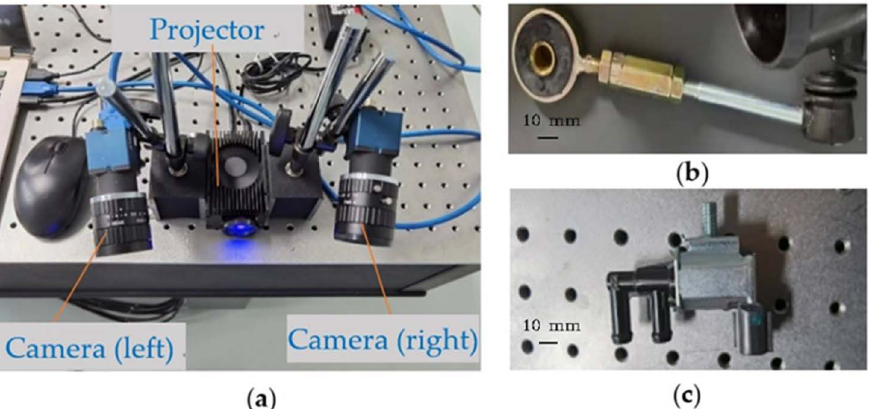
Figure 5. FPP system and industrial parts used for 3D measurement: ( a ) the FPP system built for the experiments; ( b ) an industrial part for 3D measurements in the test set; ( c ) an industrial part for 3D measurements in the training set.